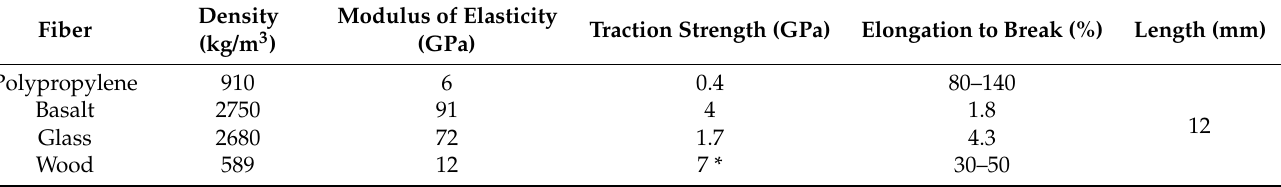
Table 3. Mechanical properties of used